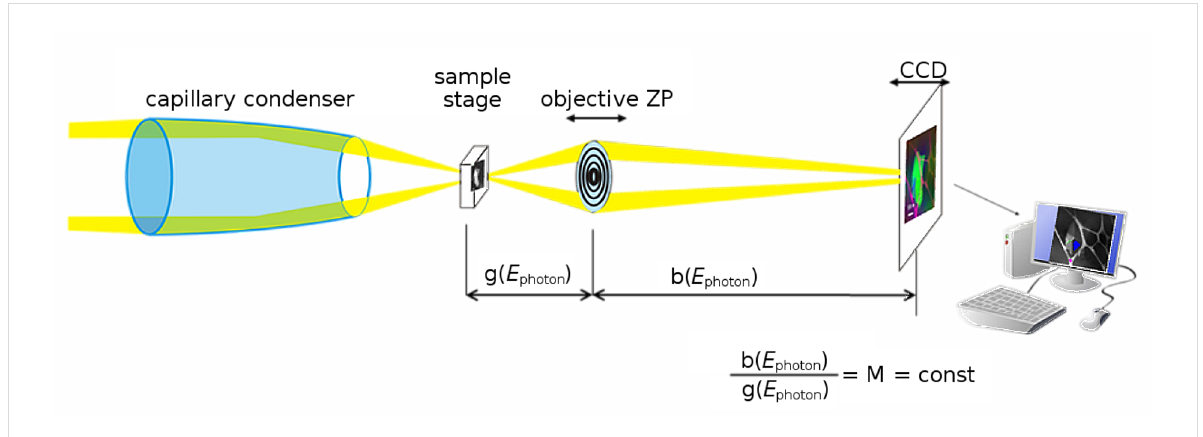
Figure 1: Schematic of the TXM for NEXAFS studies. Monochromated radiation from the undulator is focused by a reflective capillary condenser into the object field. A zone plate objective forms a magnified image on the CCD.